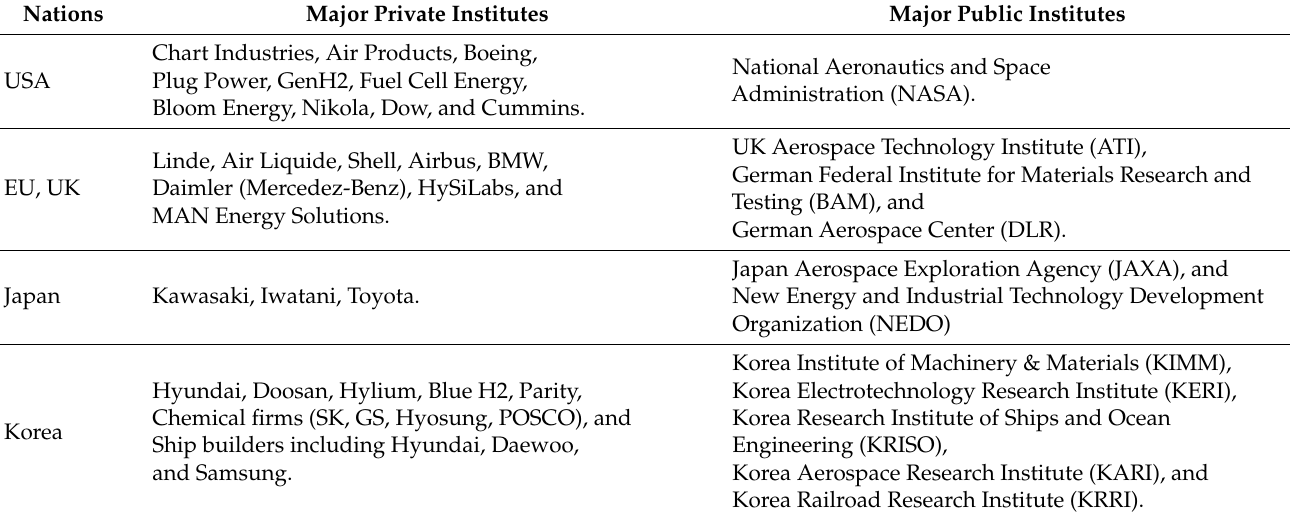
Table 1. Major institutes researching liquid